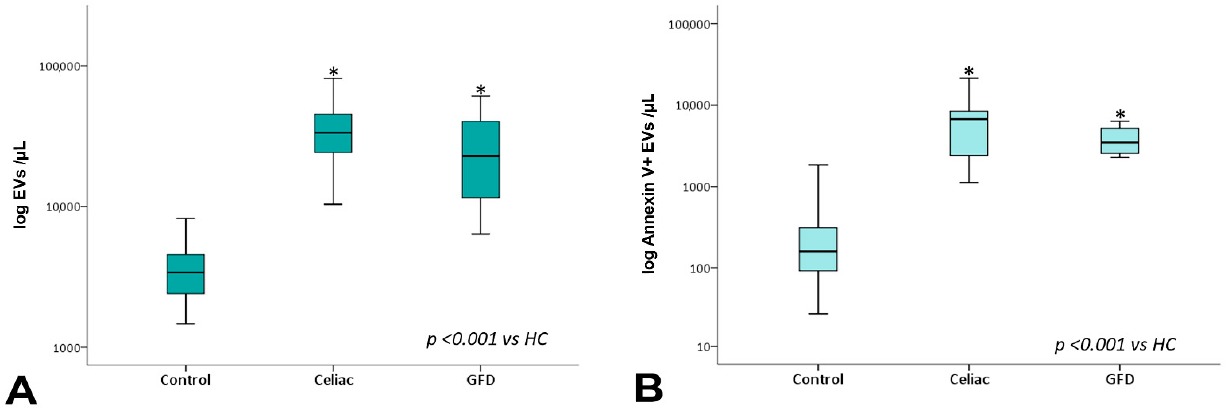
Figure 2. Total EV and annexin V+ EV counts. Box plots represent total ( A ) and total Annexin V+ ( B ) EV concentrations (EVs per μ L, log ‐ transformed) in peripheral blood obtained from controls, celiac, and celiac ‐ GFD patients. The horizontal line represents the median value. The asterisk (*) identifies statistically significant differences. Table 3. Differences in total and specific EV counts between groups 3 .